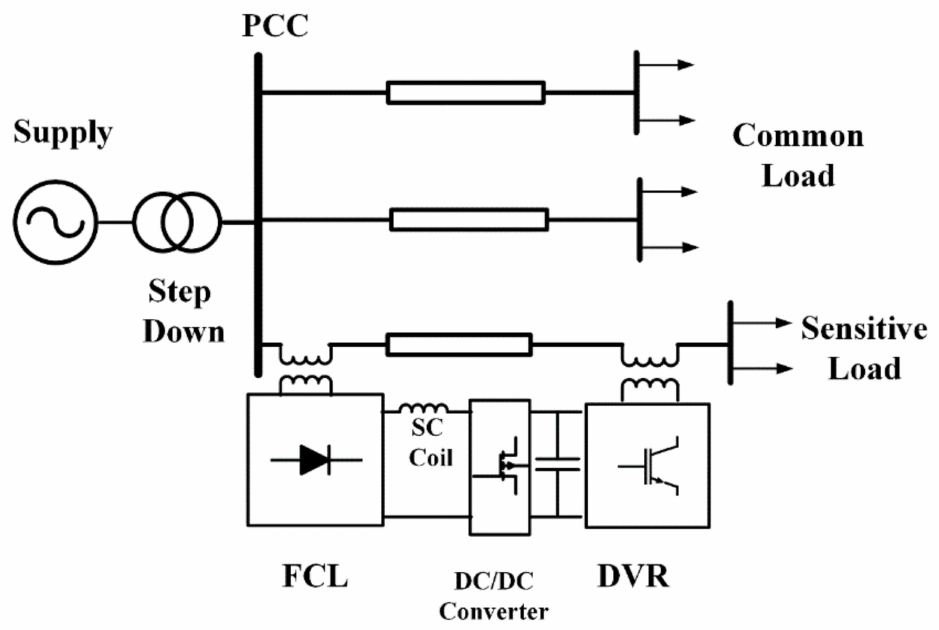
Figure 1. BSFCL-DVR